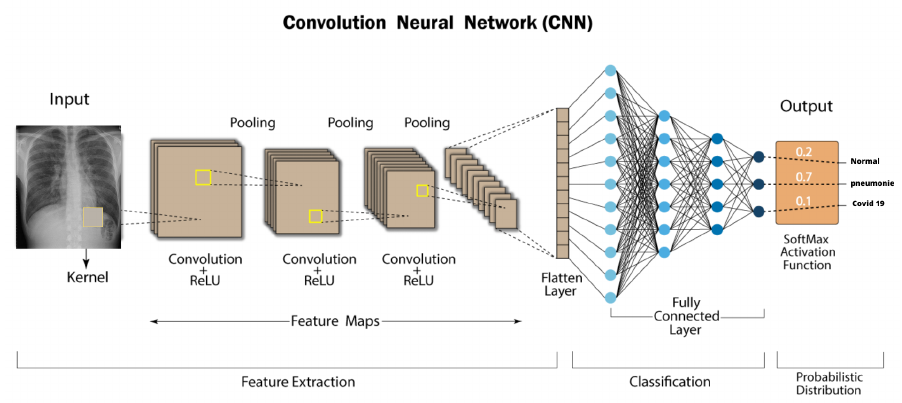
Figure 1. Convolutional